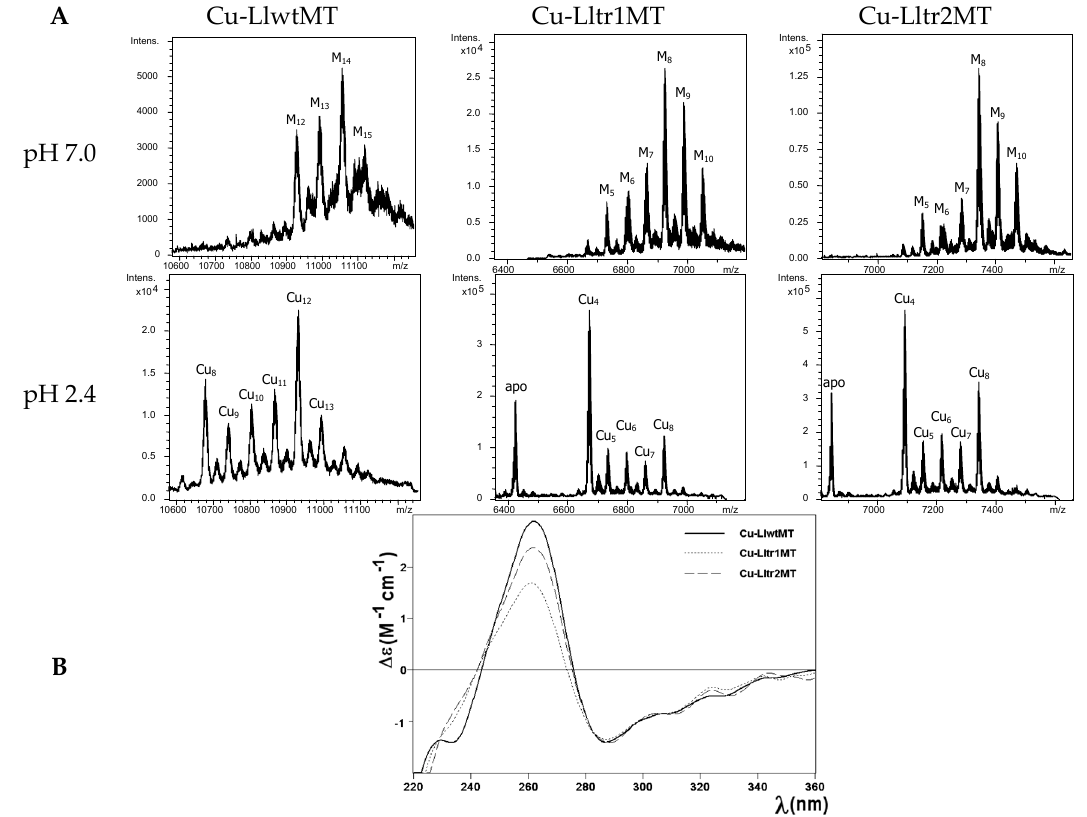
Figure 6. Analysis of the Cu-LlwtMT, Cu-Lltr1MT, and Cu-Lltr2MT complexes. ( A ) Deconvoluted ESI-MS spectra of the recombinant preparations of LlwtMT, Lltr1MT, and Lltr2MT, purified from Cu-supplemented cultures, analyzed at neutral pH (7.0) and acid pH (2.4); ( B ) CD spectra of the three recombinant Cu-LlMT preparations.